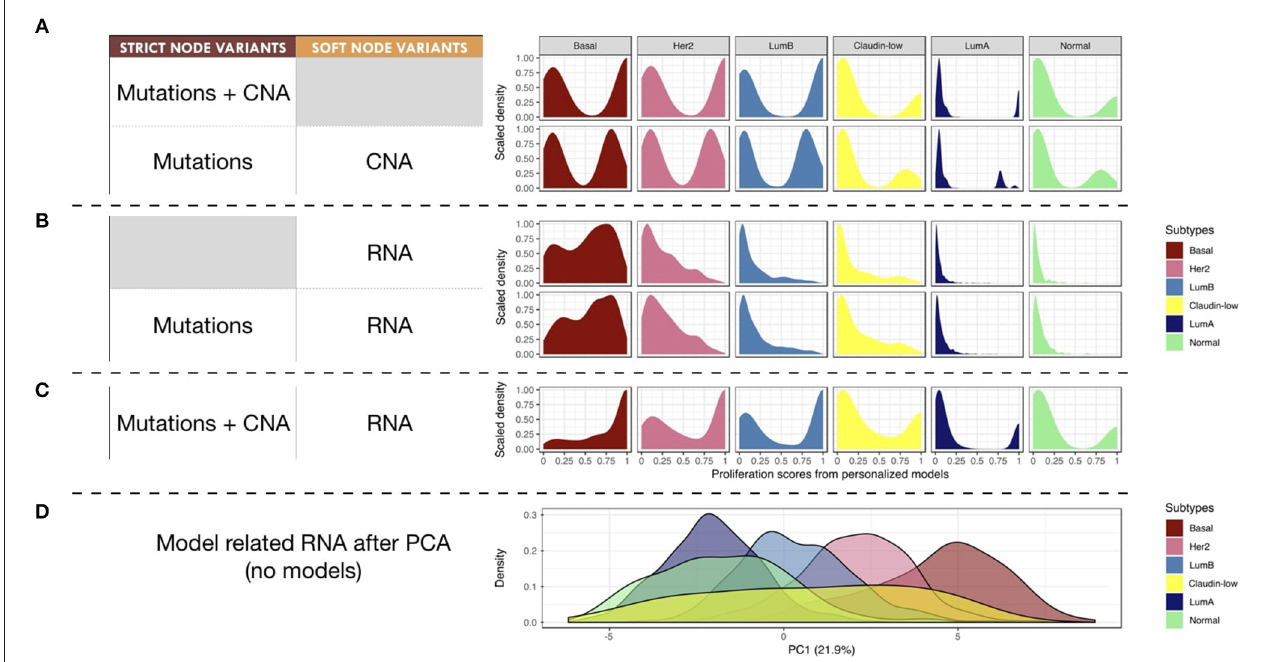
FIGURE 8 | Breast-cancer subtypes and personalized logical models. (A–C) Patterns of Proliferation probabilities per subtype with different personalization methods results in different grouping of subtypes. (D) Densities of breast-cancer subtypes along first principal component, PCA transformation based on METABRIC RNA data limited to the 114 genes described in the logical model ; percentage of variance explained by PC1 in